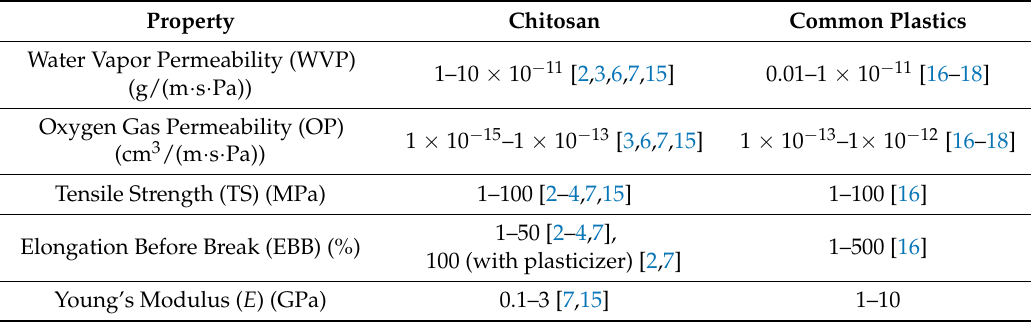
Table 1. Properties of Chitosan Films and Plastics from